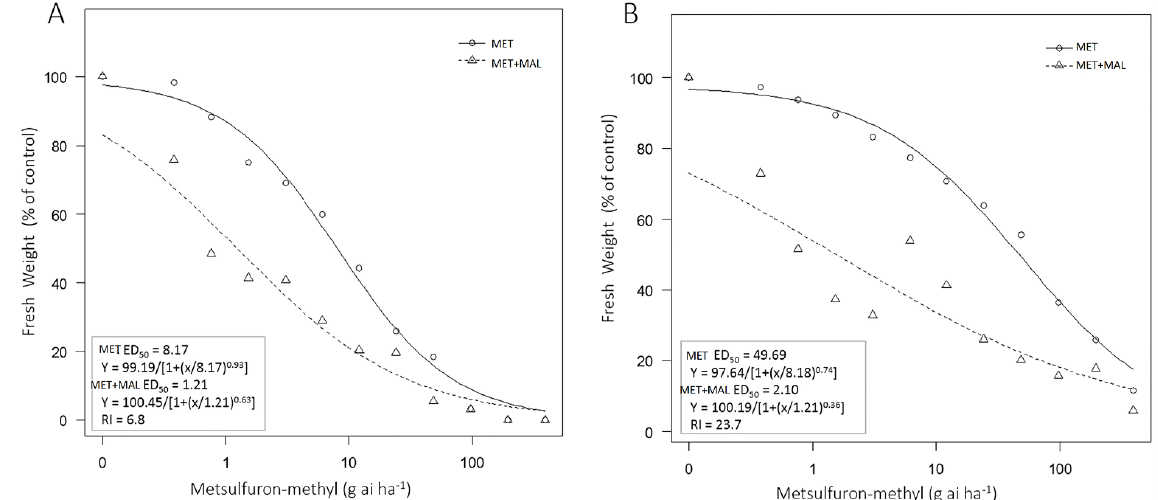
Figure 5. Dose response to metsulfuron-methyl of S and R in the absence or presence of malathion. ( A ) The S biotype; ( B ) The R biotype. MET: only metsulfuron-methyl treatment; MET+MAL: metsulfuron-methyl and malathion treatment. ED 50 : herbicide dose to inhibit growth by 50%; RI: resistance